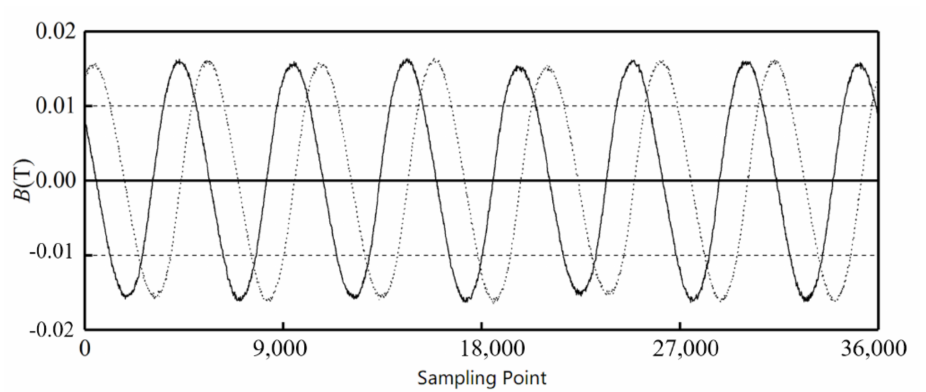
Figure 13. Signals from Hall sensors of inner alnico.